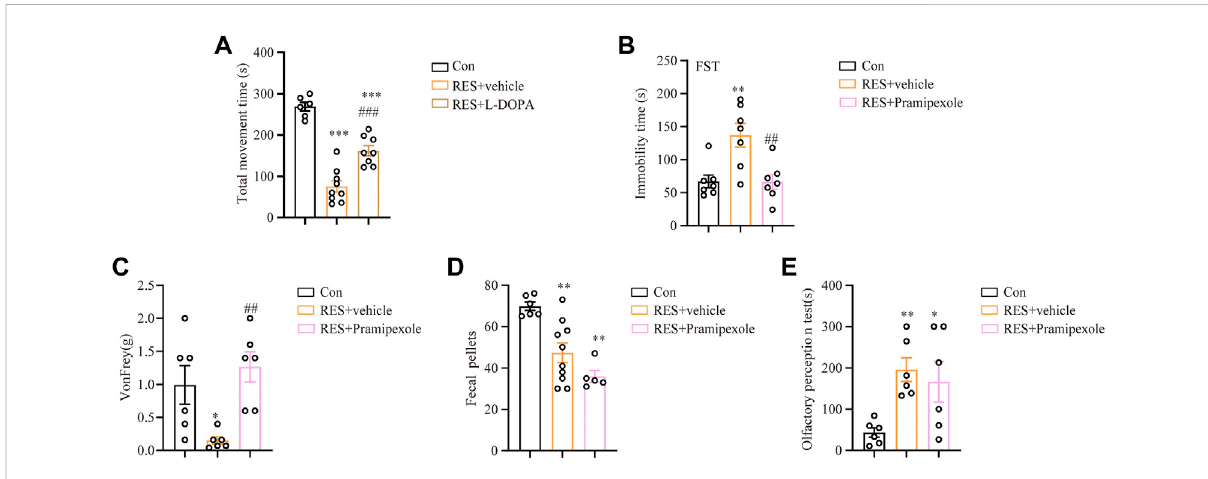
FIGURE 7 Effects of L-DOPA and pramipexole against reserpine-induced PD-like symptoms. (A) L-DOPA increased the movement time against reserpine-induced reduction in mice (n = 9 for each group, one-way ANOVA with Tukey ’ s post hoc test, *** p < 0.001 vs. control; ### p < 0.001 vs. RES). (B) The immobility time in the forced swimming test decreased upon pramipexole treatment in reserpine-induced mice ( n = 7 for each group, one-way ANOVA with Tukey ’ s post hoc test, ** p < 0.01 vs. control; ## p < 0.01 vs. RES). (C) Pramipexole upgraded the mechanical